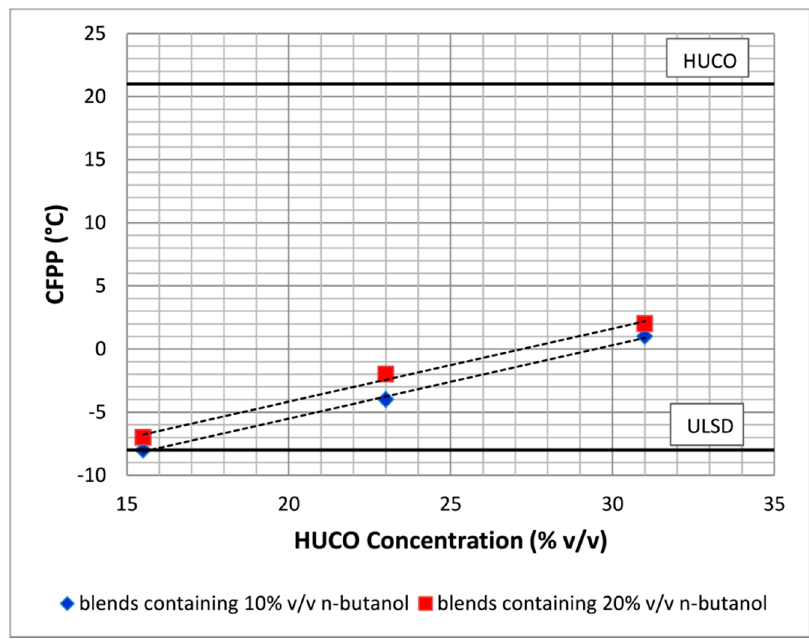
Figure 7. Cold filter plugging point (CFPP) of ternary blends containing n -butanol, ULSD, and HUCO according to Equation (1).